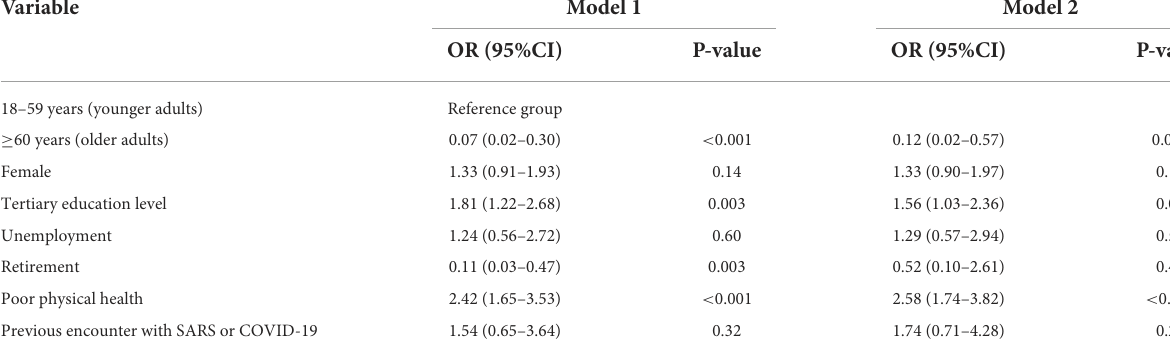
TABLE 3 Regression analysis of determinants of common mental disorders